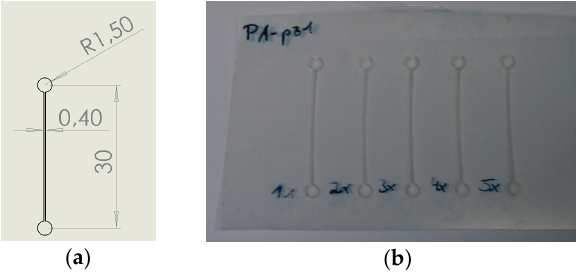
Figure 1. ( a ) Layout design of the single microchannel; ( b ) First tape sample structured by using a CO 2 laser with optimized power of ~ 2 W. This sample includes an array of five